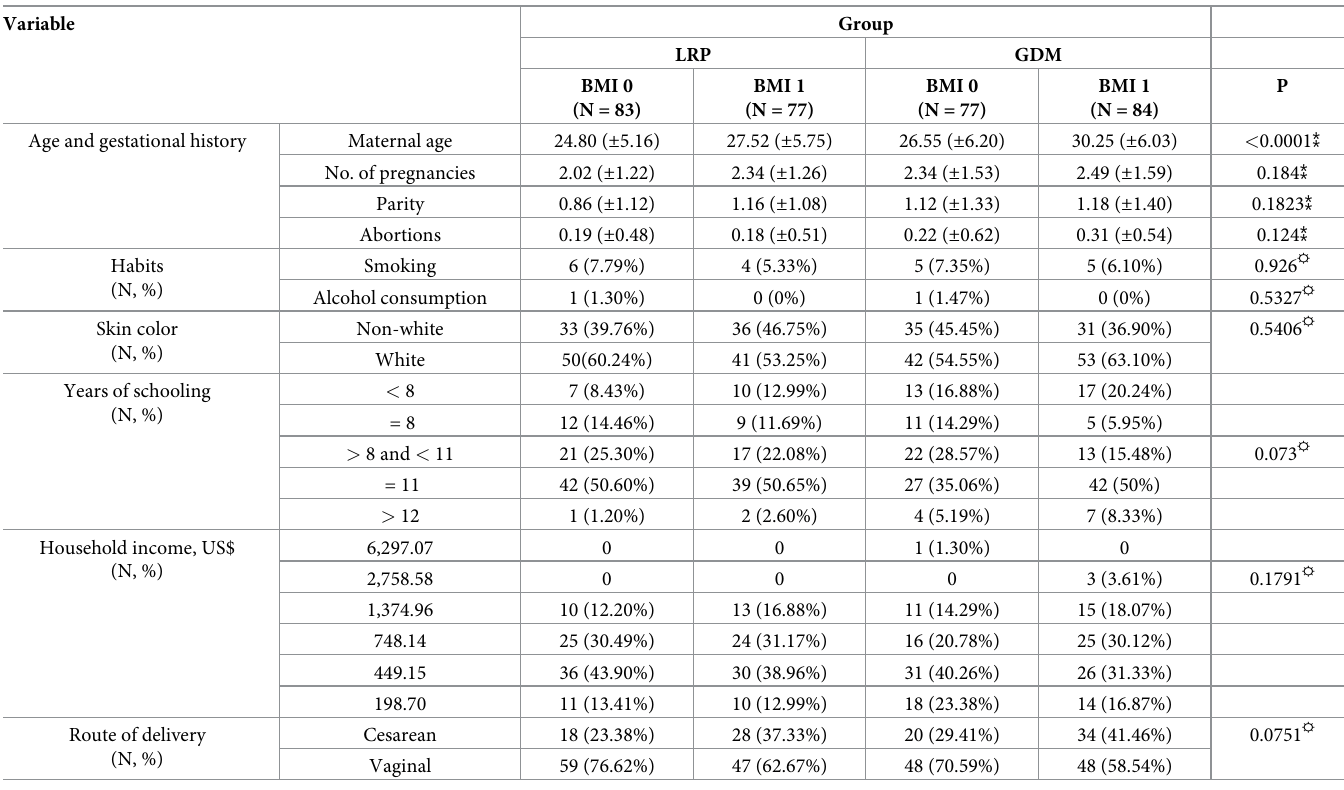
Table 1. Maternal clinical and sociodemographic characteristics (N = 321).